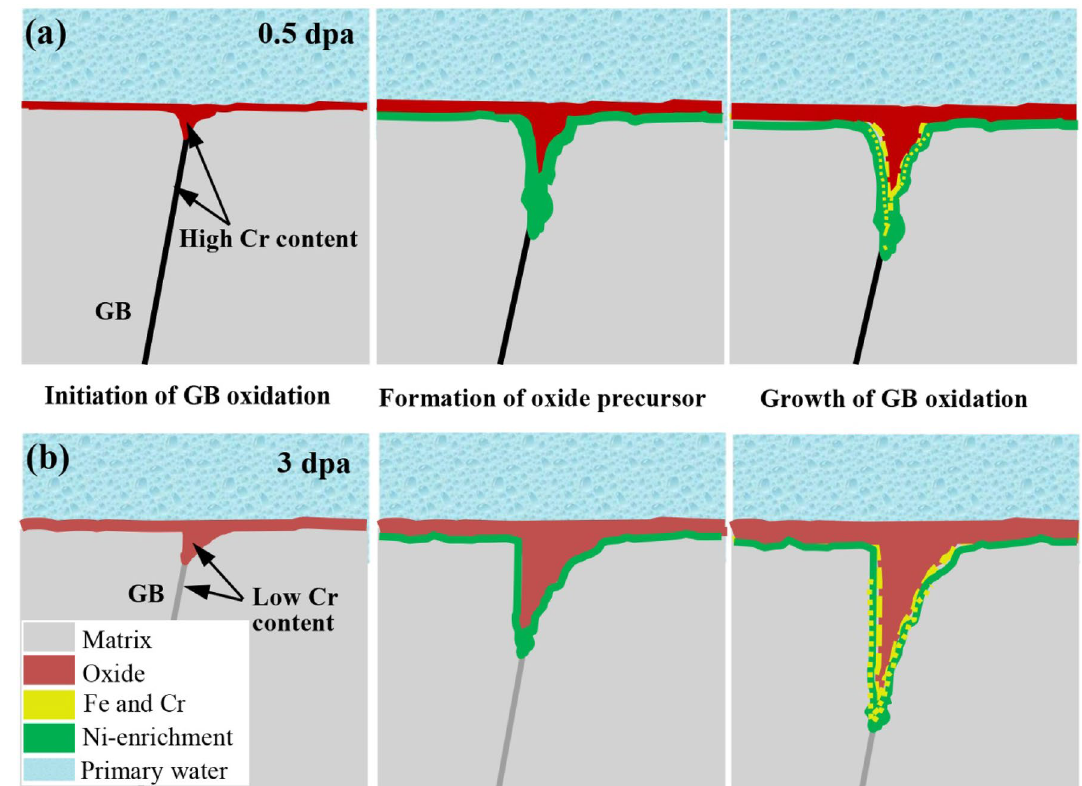
Figure 6. Schematics showing the effect of oxide microstructure on grain boundary oxidation on the ( a ) 0.5- and ( b ) 3-dpa irradiated specimens in primary water at 320 °C. *Schematics in this figure were made using the PPT Software package (Office, Version